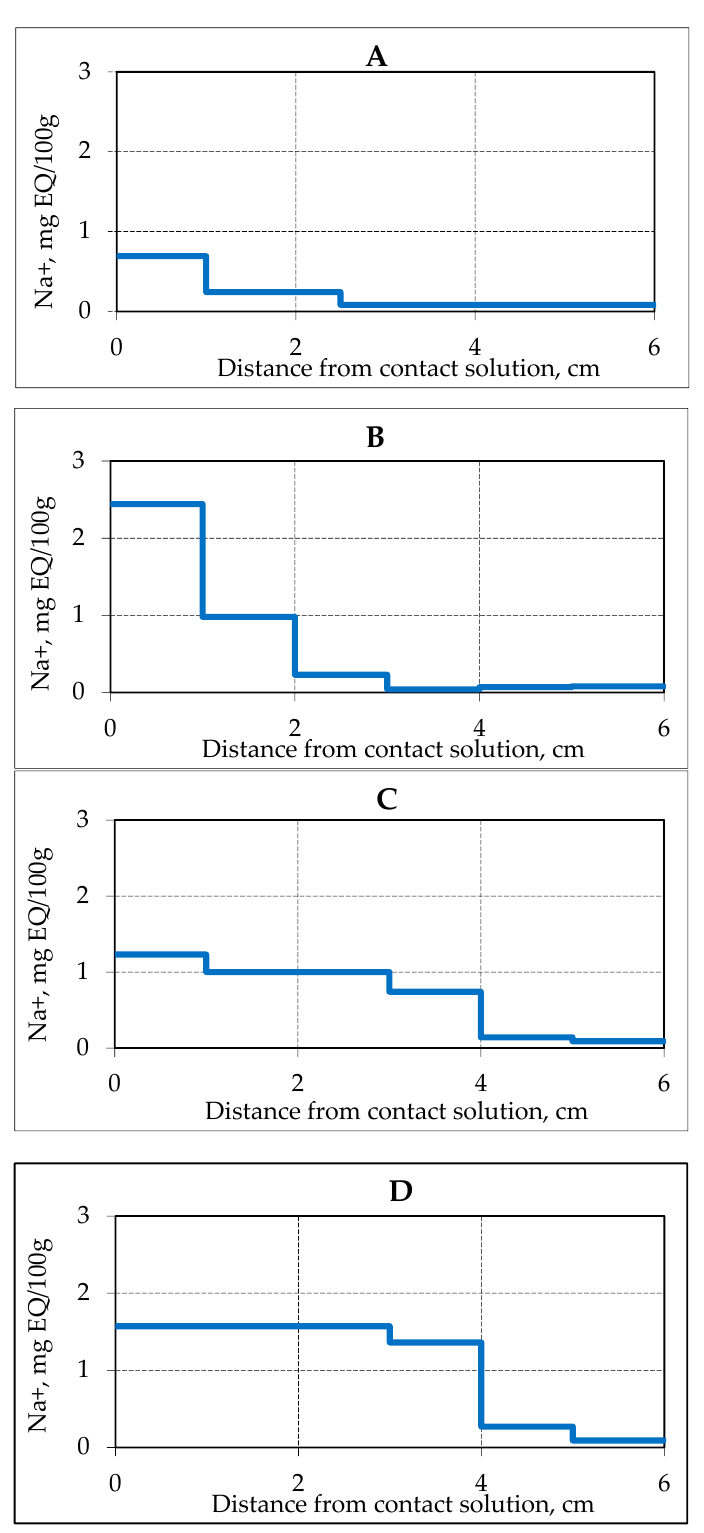
Figure 2. Accumulation of Na + ions in samples of frozen hydrate saturated sand (sand 1, W = 14%) in time when interacting with 0.2 N NaCl solution at a temperature of − 4 °C. A – D is the time of interaction with the salt solution, respectively, 3.9, 17.5, 25.5 and 28.8 h.